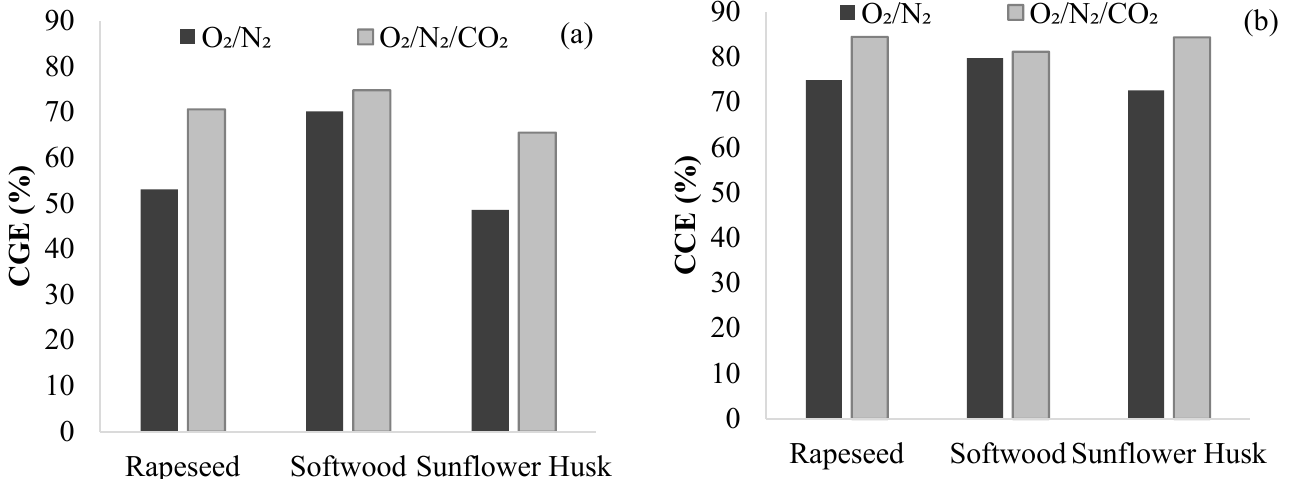
Figure 3. Effect of biomass and gasifying agent on ( a ) calculated cold gas efficiency (CGE) and ( b ) carbon conversion efficiency (CCE).